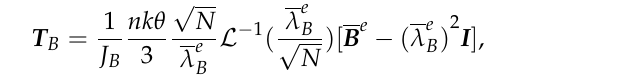
(cid:82) d ε vp eq ε